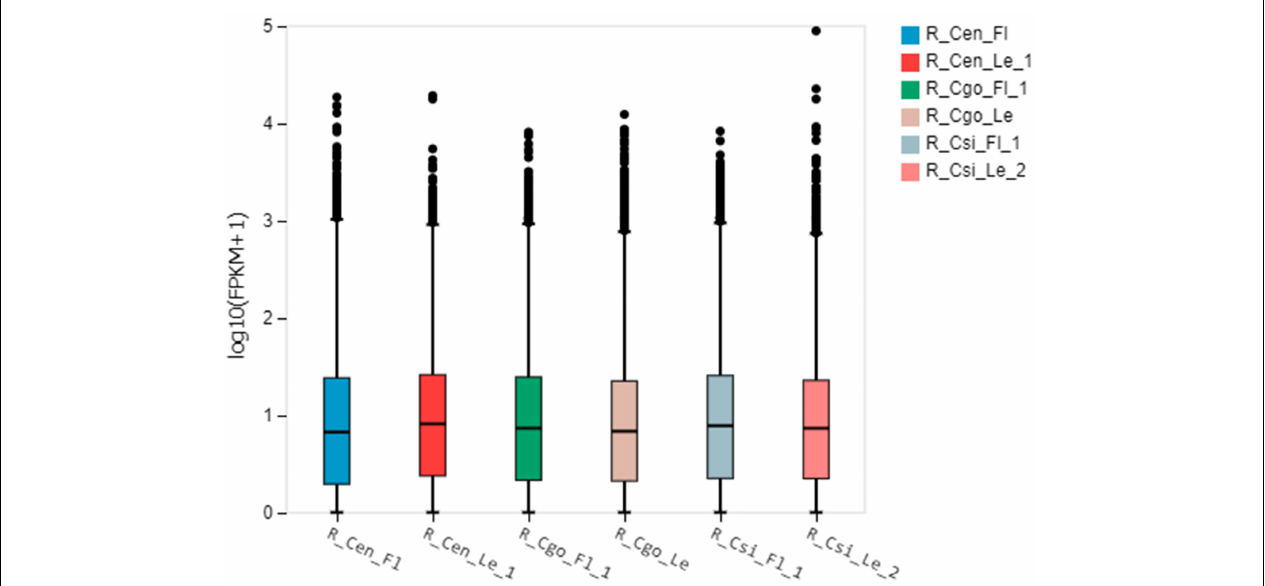
FIGURE 2 | The boxplot shows the distribution of gene expression levels in each sample, and the degree of dispersion of the data distribution can be observed. The X -axis is the sample name, the Y -axis is log10(FPKM + 1), and the boxplot of each area corresponds to five statistics (from top to bottom are the upper limit, upper quartile, median, and lower quartile, respectively). Number of digits, lower bound, where upper and lower bounds do not account for outliers.